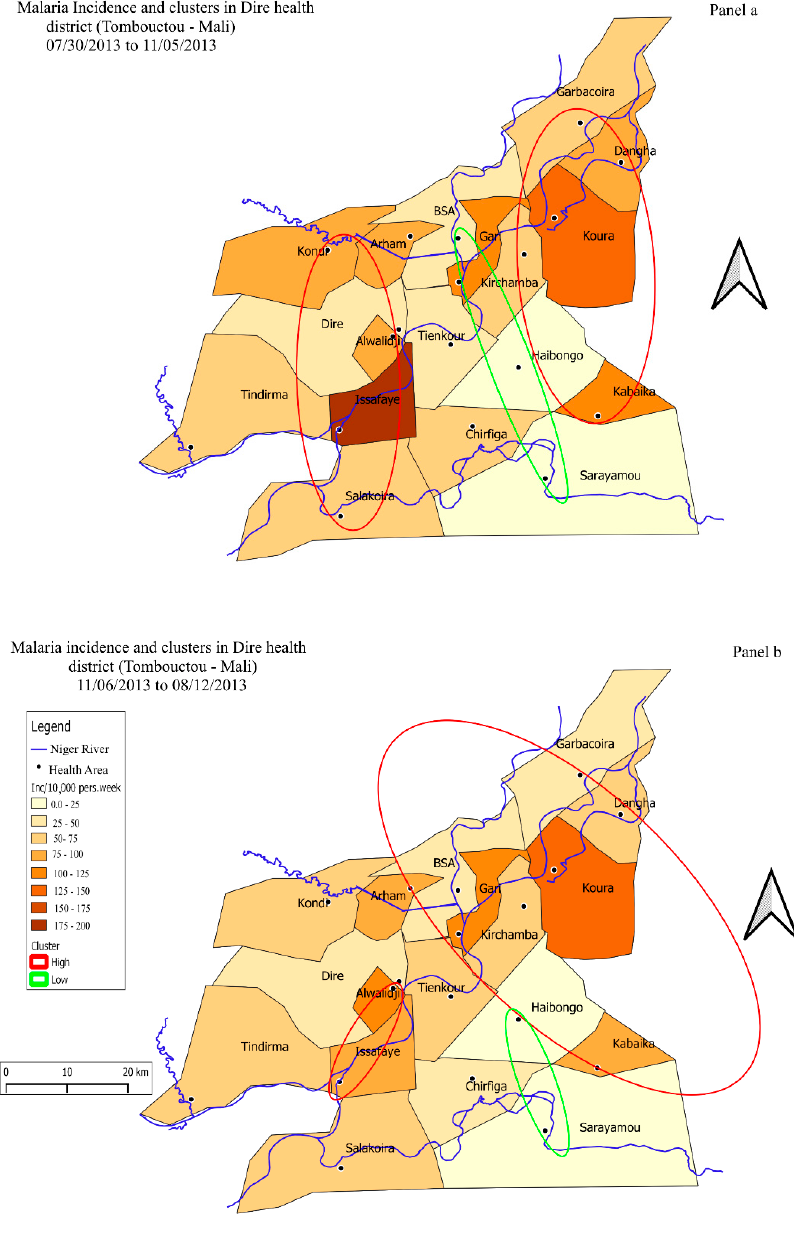
Figure 3. Map of malaria incidence and clusters (hotspots and coldspots) per health area. Panel ( a ): Rainy season. Panel ( b ): Dry season.